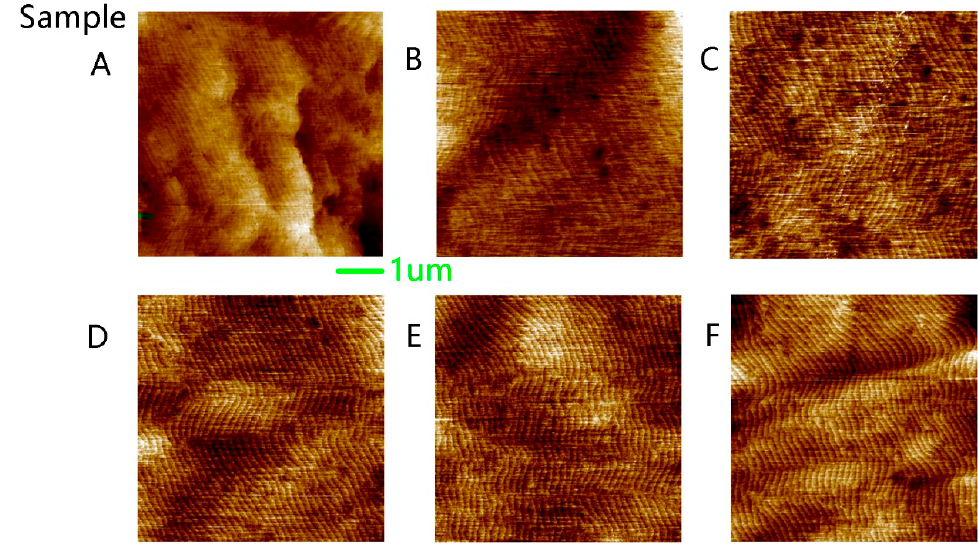
Figure 2. The 5 × 5 μ m AFM images of samples ( A – F ). Table 3. The crystalline quality indexes of 6 AlGaN